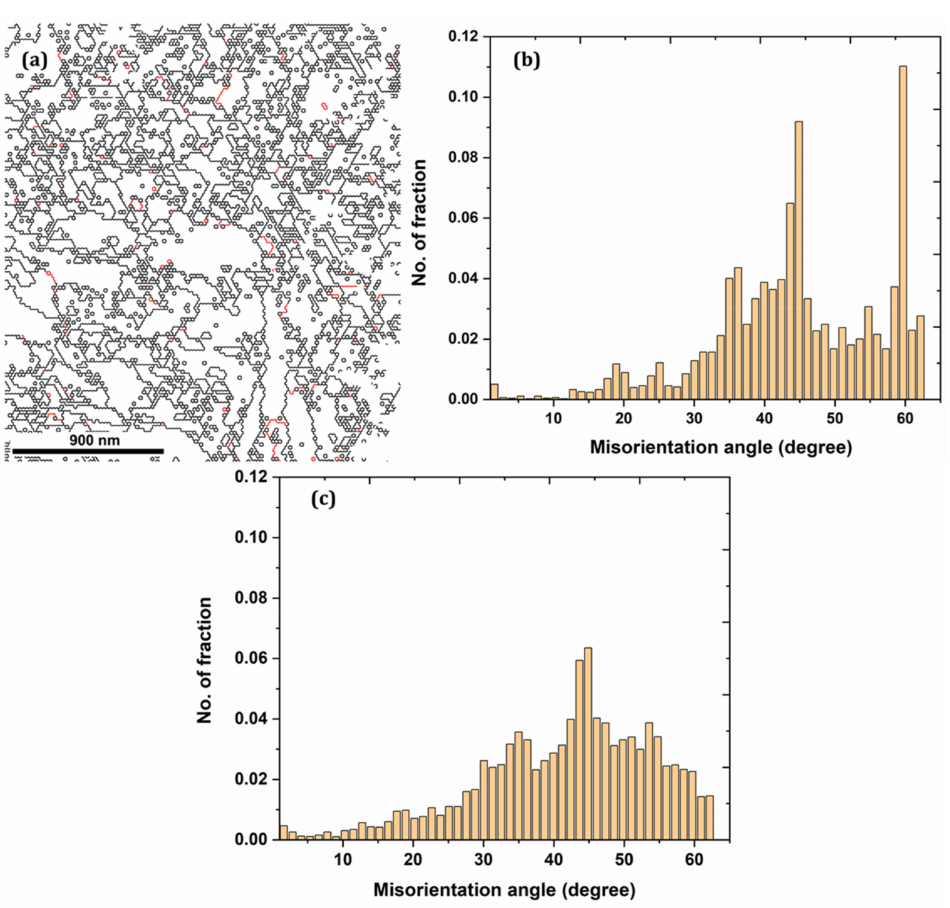
Figure 3. ( a ) High- and low-angle grain boundary distribution; ( b , c ) Misorientation angles for the austenite and ferrite phases, respectively.